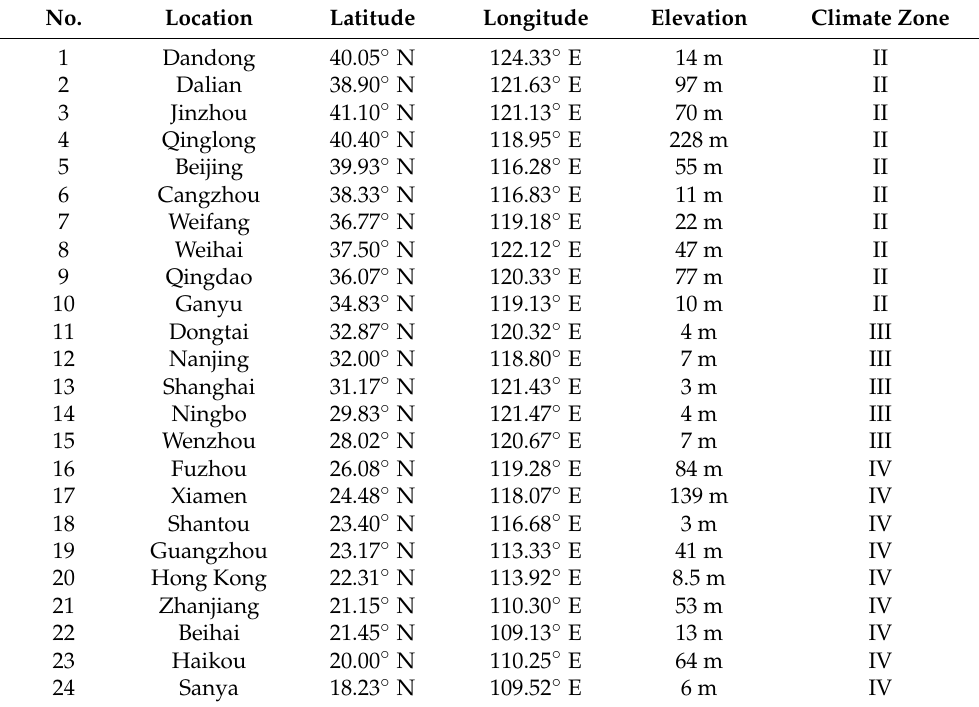
Table 4. Characteristics of cities in this